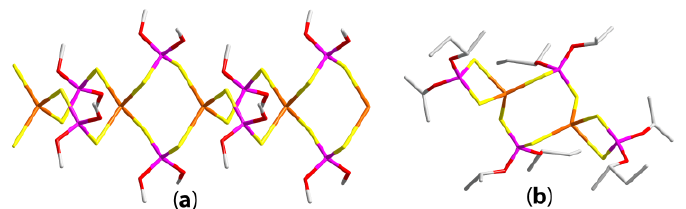
Figure 6. Aggregation in the crystals of ( a ) {Cd[S 2 P(OMe) 2 ] 2 } n ( 25 ) and ( b ) {Cd[S 2 P(O-s-Bu) 2 ] 2 } 2 ( 30 ).